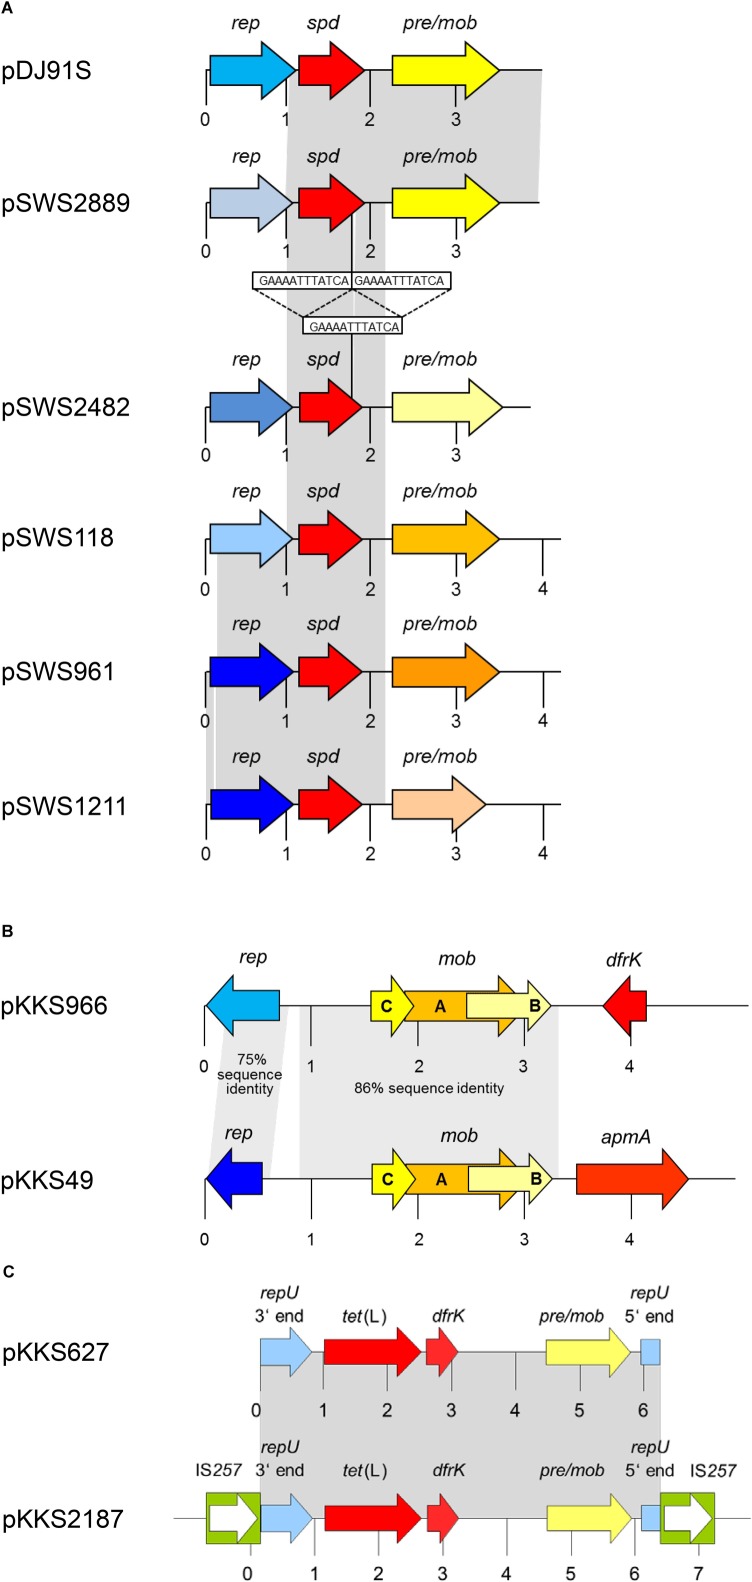
Schematic presentation of (A) the spd-carrying plasmids pDJ91S and pSWS2889 from MRSA ST398 in comparison to closely related plasmids pSWS2482 and pSWS1211 from S. hyicus, pSWS118 from S. chromogenes, and pSWS961 from S. equorum, (B) the apmA-carrying plasmid pKKS49 from MRSA ST398 and the dfrK-carrying plasmid pKKS966 from S. hyicus, and (C) the dfrK-carrying plasmid pKKS627 and the dfrK region of plasmid pKKS2187, both from MRSA ST398. The reading frames are presented as arrows with the arrowhead indicating the direction of transcription. A distance scale in kb is given below the maps. The resistance genes are indicated in red, plasmid replication genes rep in different shades of blue, and genes involved in plasmid recombination and mobilization, pre/mob and mob, in different shades of yellow/-orange. The different blue and yellow-orange shadings indicate differences in the respective genes. The IS257 elements in panel (C) are displayed as green boxes with the white arrow inside indicating the transposase gene tnp. The gray-shaded areas represent areas of at least > 99% sequence identity unless otherwise indicated. This figure is modified from Kadlec et al. (2012a) and Wendlandt et al. (2015b).